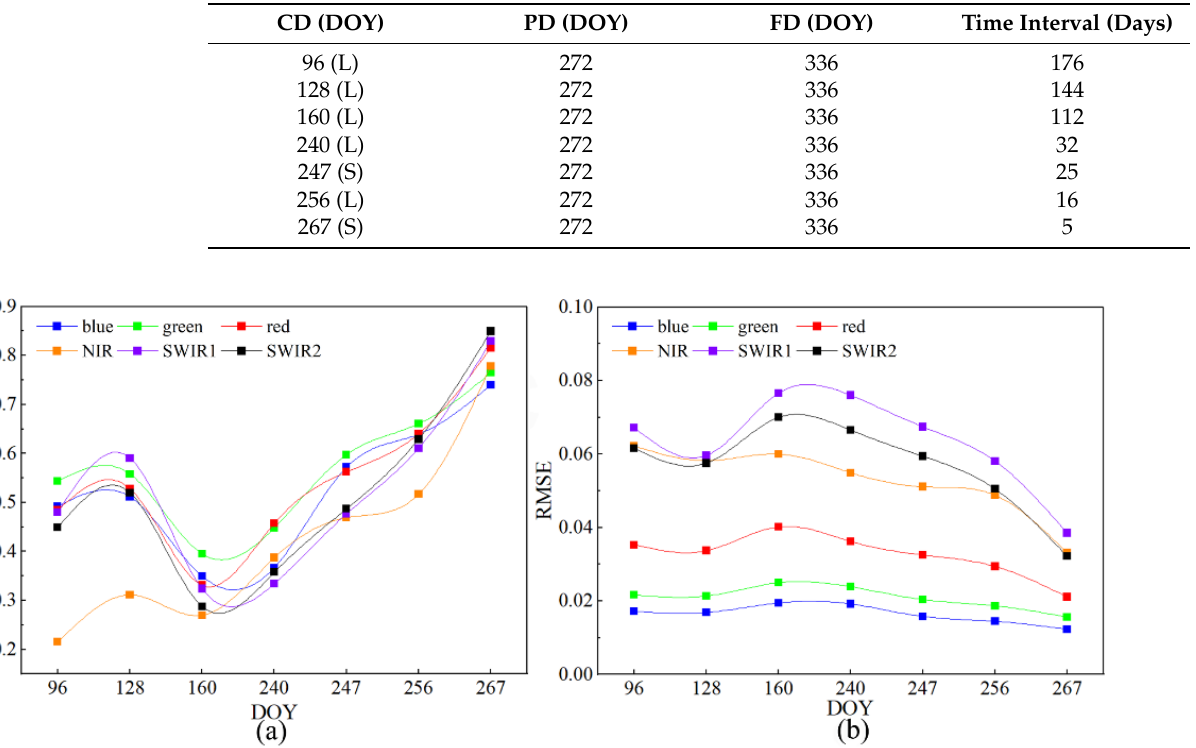
Table 3. Data selected for NMC period. Figure 11. The standard false-color-composited images of the fused results and the true image at the PD are shown in Figure 12.